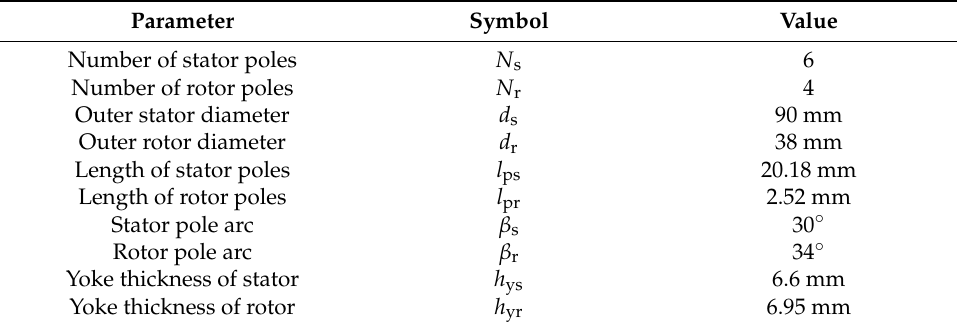
Table 1. Summary of the mechanical parameters of the basic high-speed SRM